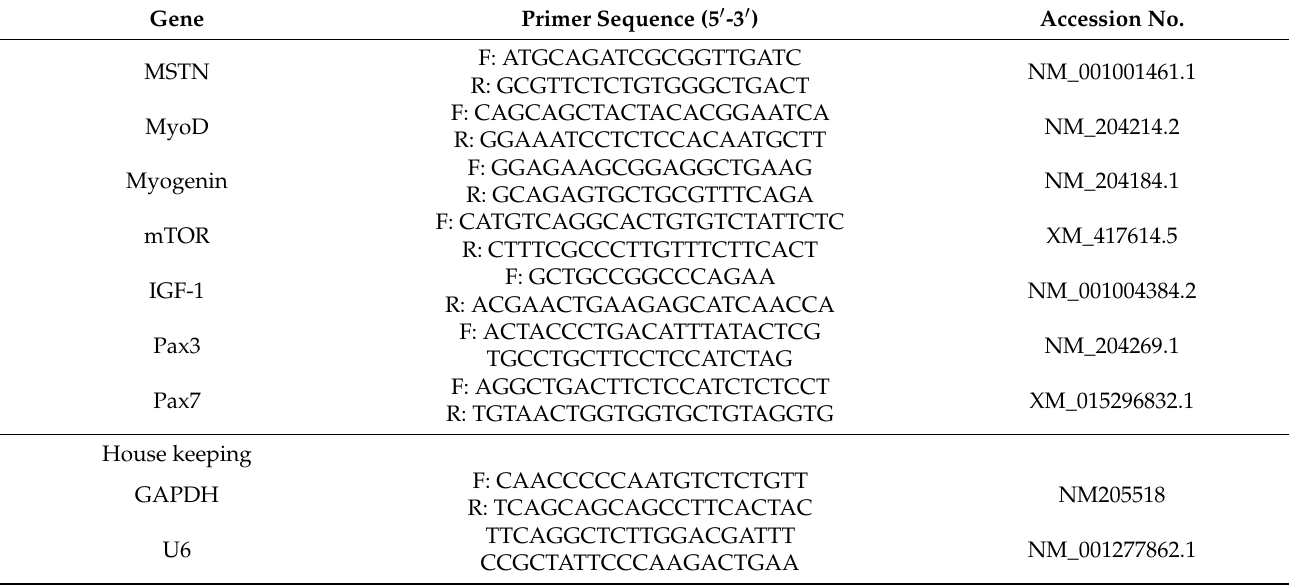
Table 2. Primer sequences and target genes used for real-time qPCR